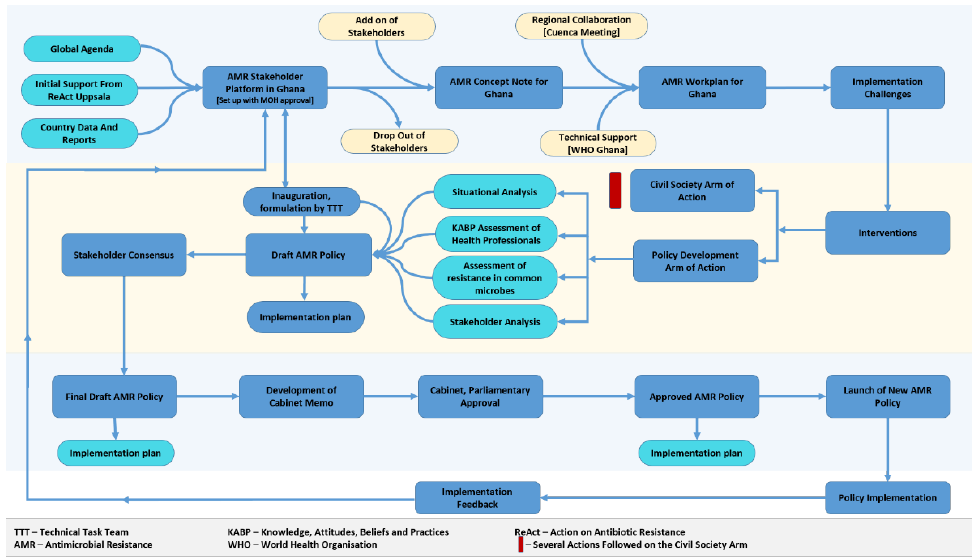
Figure 2. AMR Policy Flow. Own design, based on [15].